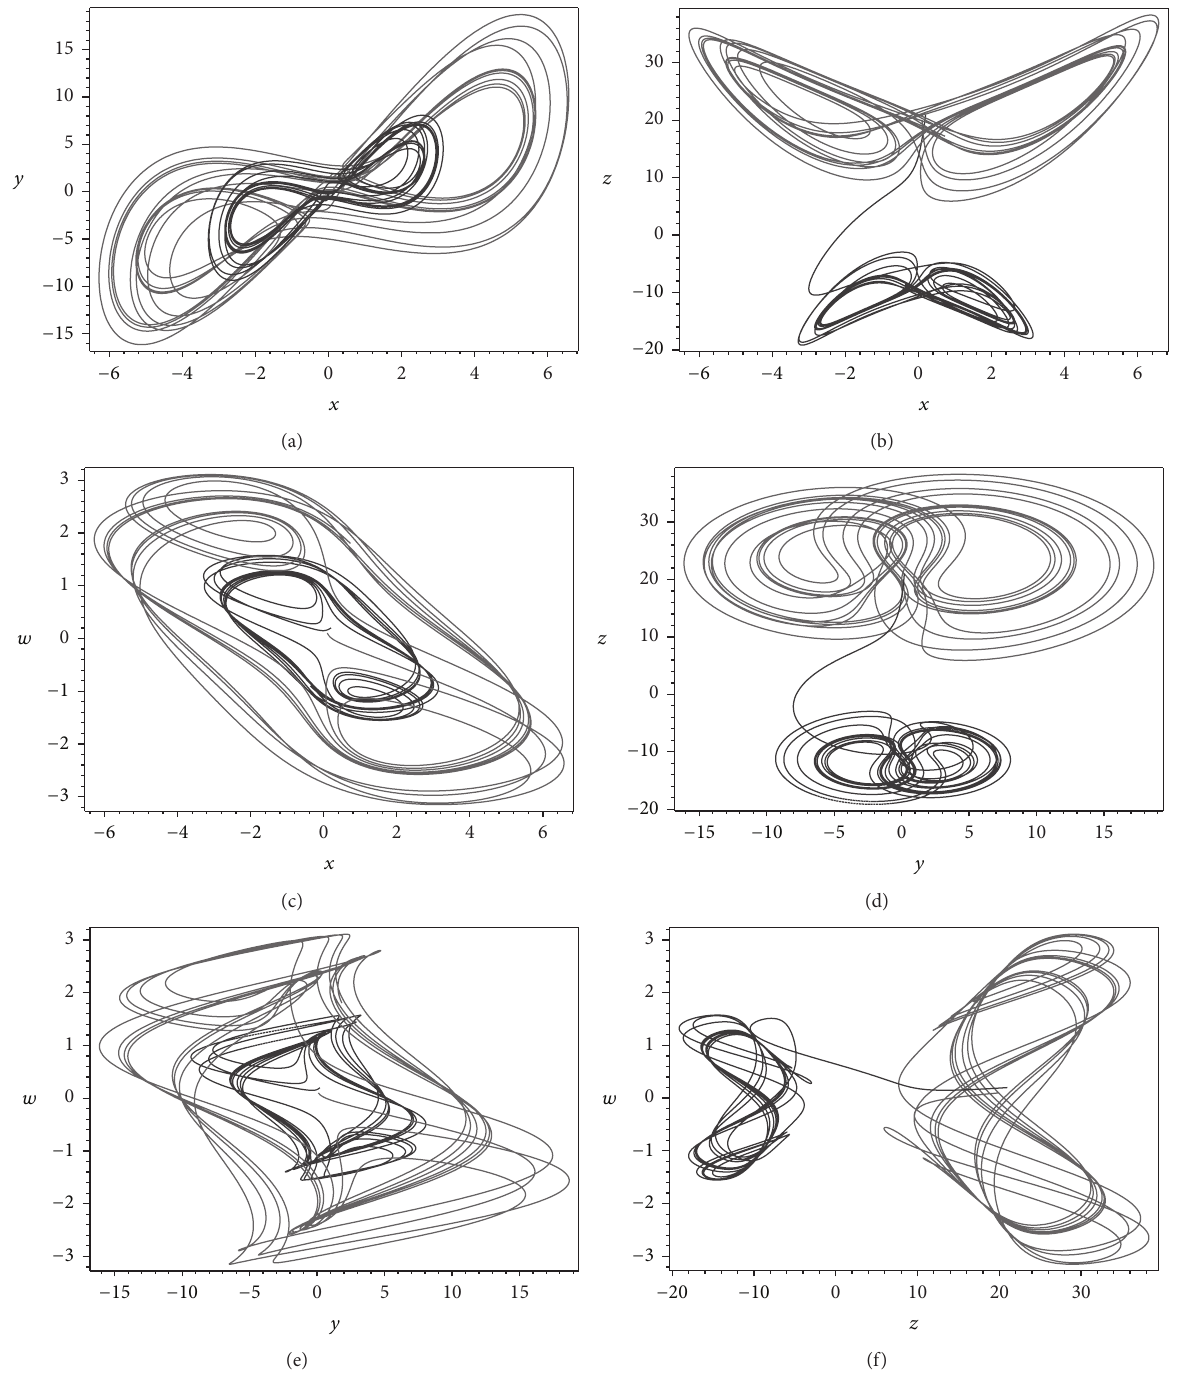
Figure 10: Simulated phase portraits of the chaotic system (1), projected on (a) the 𝑥 - 𝑦 plane, (b) the 𝑥 - 𝑧 plane, (c) the 𝑥 - 𝑤 plane, (d) the 𝑦 - 𝑧 plane, (e) the 𝑦 - 𝑤 plane, and (f) the 𝑧 - 𝑤 plane. and the system related to (36), given